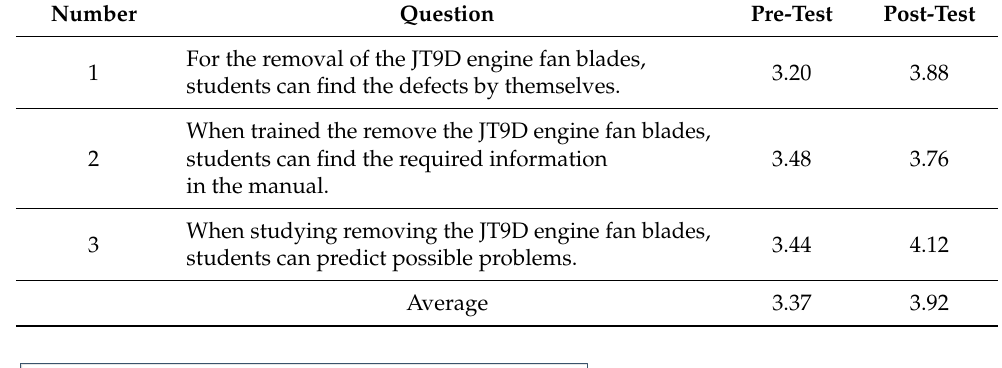
Table 3. Results for problem organization.